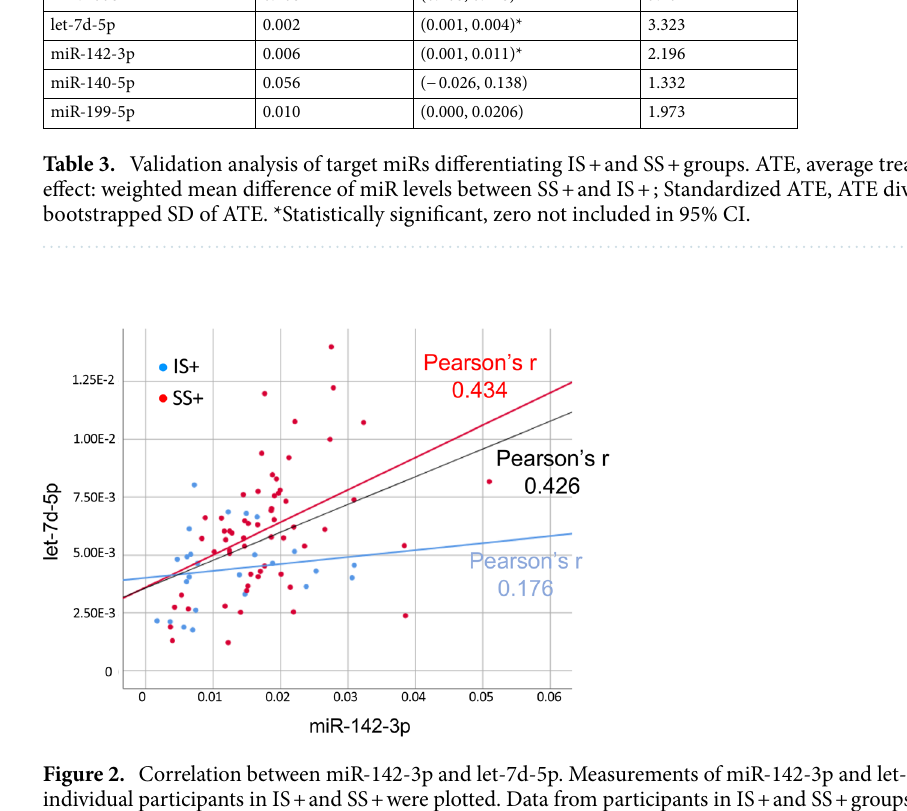
Supplementary Fig. S3. This pathway is a potential mechanism underlying prolonged sitting among overweight/ obese postmenopausal women. Discussion